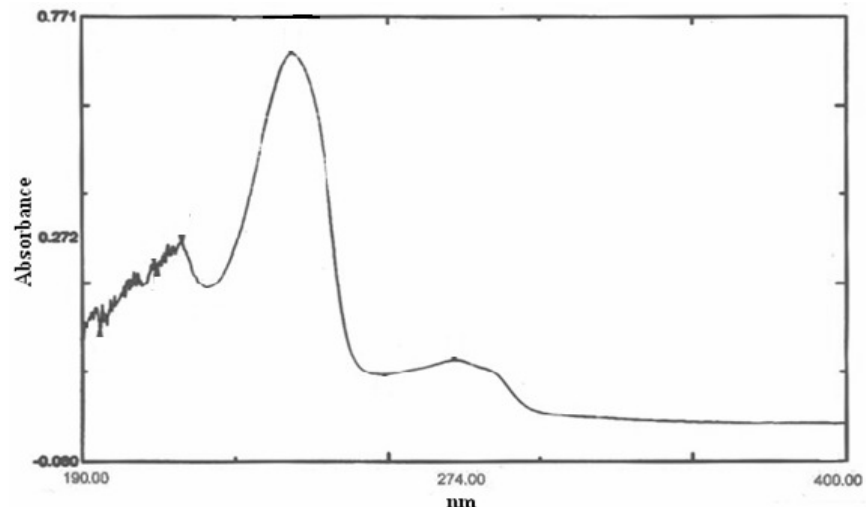
Figure 1 . Spectra of 5µg/mL solution of efavirenz in 1%w/v sodium lauryl sulphate. Table 1 . Calibration curve points of the proposed method for the estimation of efavirenz.